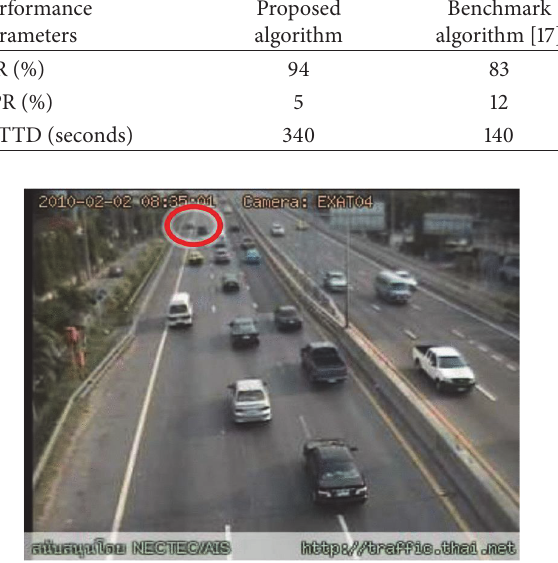
Figure 8: An anomaly detected at the 4th camera sensor.